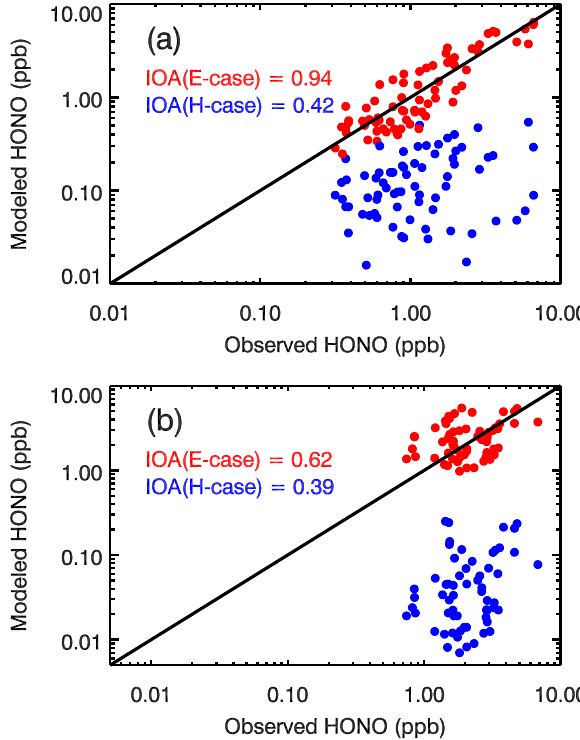
Fig. 5. Comparison between simulated and observed HONO at T0 during (a) daytime and (b) nighttime. The red and blue dots repre- sent the simulations in the E-case and H-case,